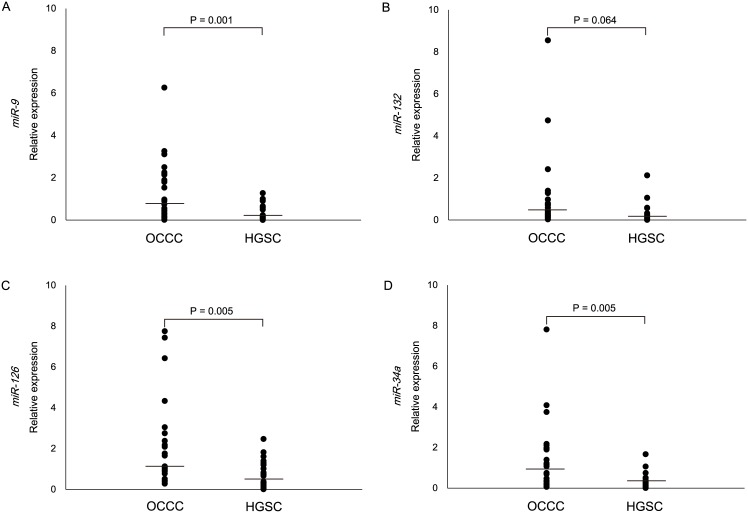
Validating original data by individual real-time RT-PCR analysis for both cohorts.Individual Taqman MicroRNA assays were used to analyze the relative expression of miR-9 (A), miR-132 (B), miR-126 (C), and miR-34a (D) in the original 27 and additional 23 cases. Horizontal lines inside dots represent the median values.